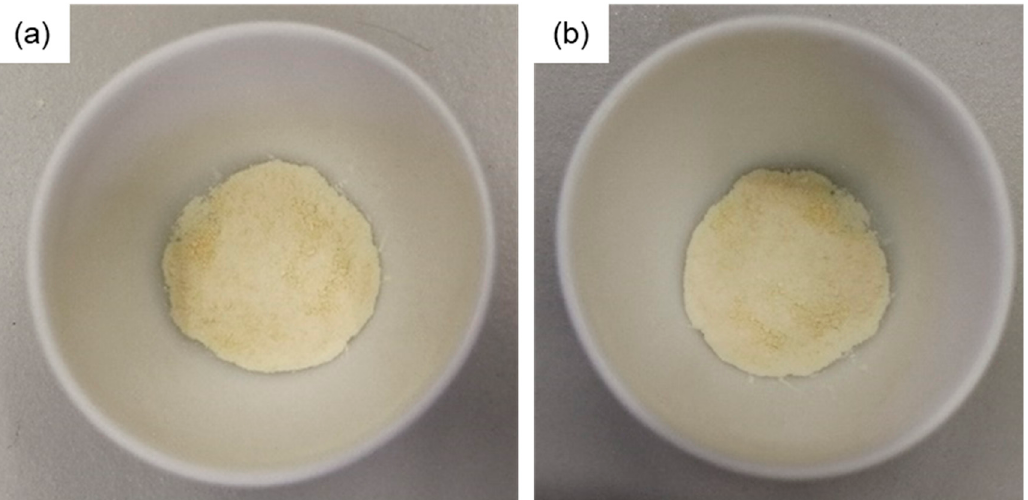
Figure 7. Pictures of CaHS ( a ) after the dehydration process in a furnace at 150 ◦ C for 2 h and ( b ) after the rehydration process at 30 ◦ C (RH = 100%) for 2